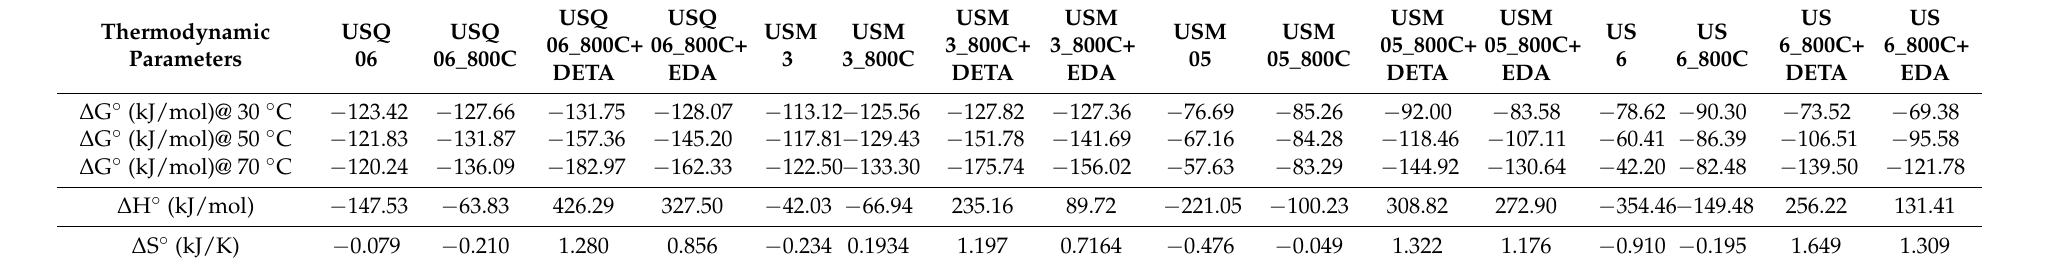
Table 7. Thermodynamic parameters obtained from the experimental data at 30 ◦ C, 50 ◦ C, and 70 ◦